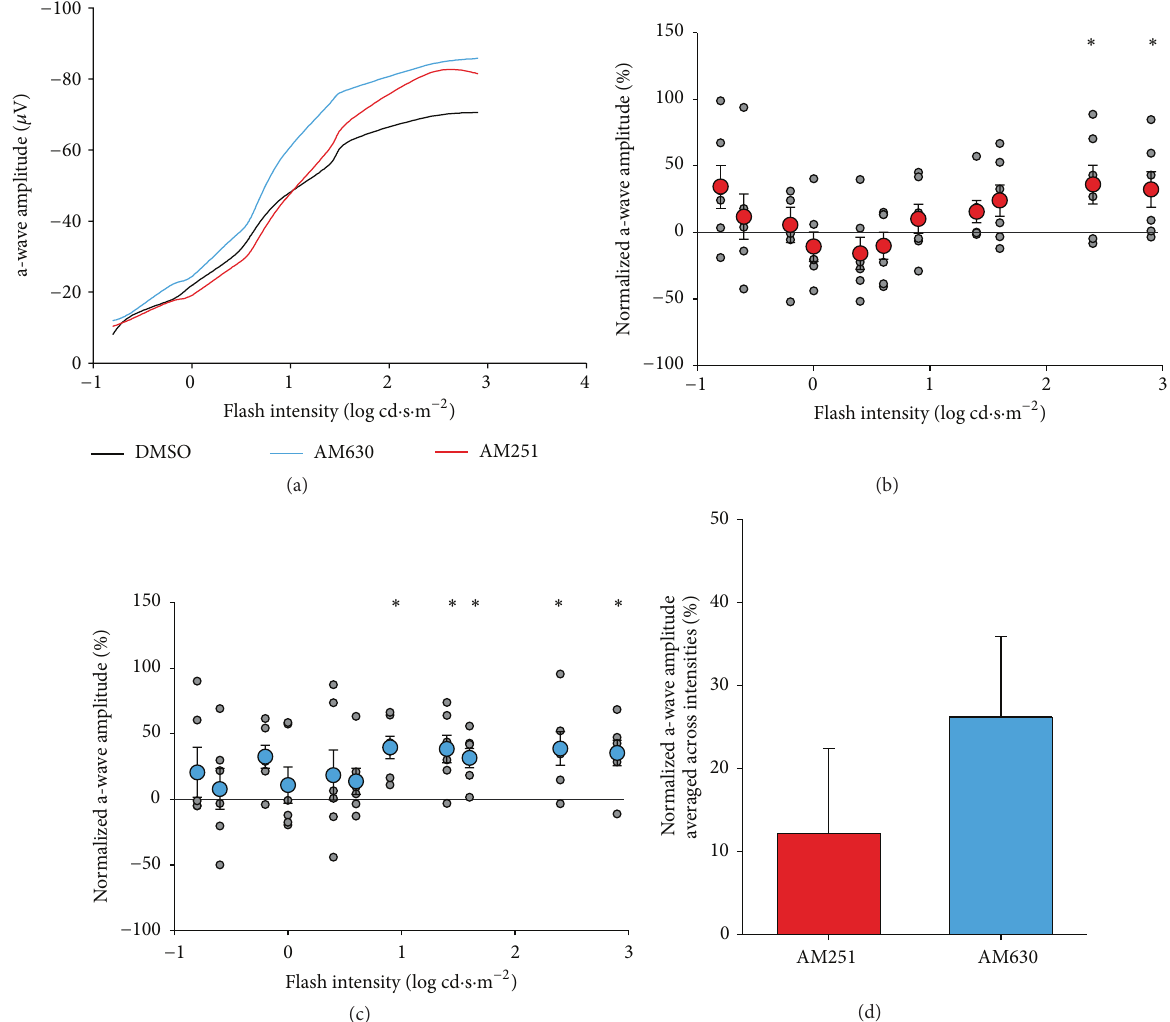
Figure 4: Photopic a-wave amplitudes. (a) Amplitudes of photopic ERG a-waves plotted as a function of flash intensities. (b) Scatter plot for normalized a-wave amplitude as a function of flash intensity in AM251-injected monkeys. Grey points indicate raw values; red data points with error bars indicate the mean and standard error of the mean. (c) Scatter plot and linear regression for normalized a-wave amplitude as a function of flash intensity in AM630-injected monkeys. Grey points indicate raw values; blue data points with error bars indicate the mean and standard error of the mean. (d) Main effect of average amplitudes across intensities in AM251 (red) or AM630 (blue) groups. ∗ 𝑝 < .05 .